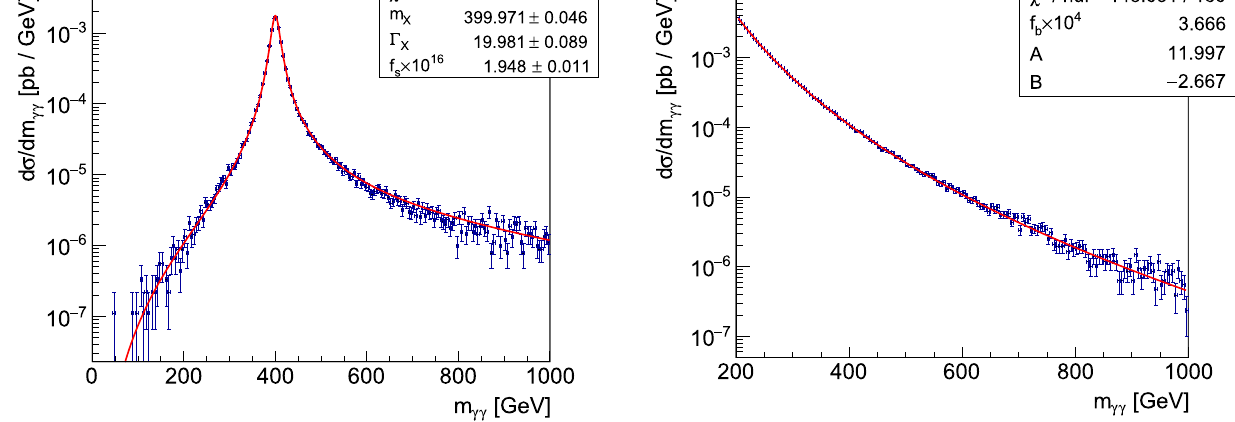
Fig. 3 A fit of the background template functional form to the his- togram of generated background gg → γγ